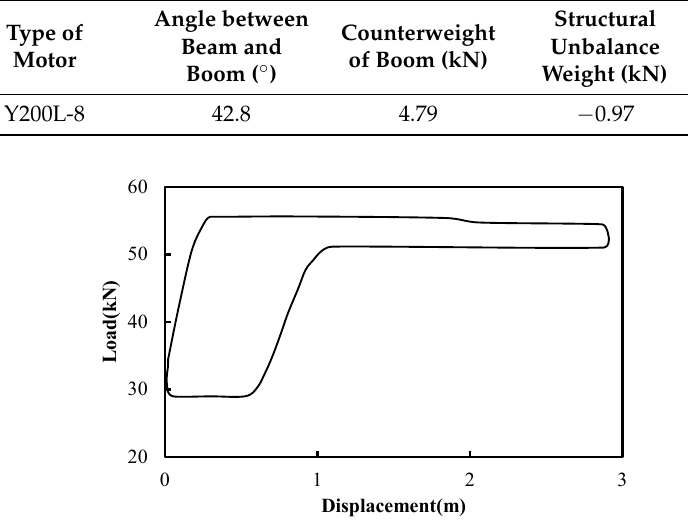
Figure 6. Measured electric power diagram. According to the measured dynamometer card of well X 1 (Figure 5), the calculated electric power diagram is compared with the measured electric power diagram (Figure 6) by using the calculation model, as shown in Figure 7. Figure 7. Measured and calculated the electric power diagram of well X1.